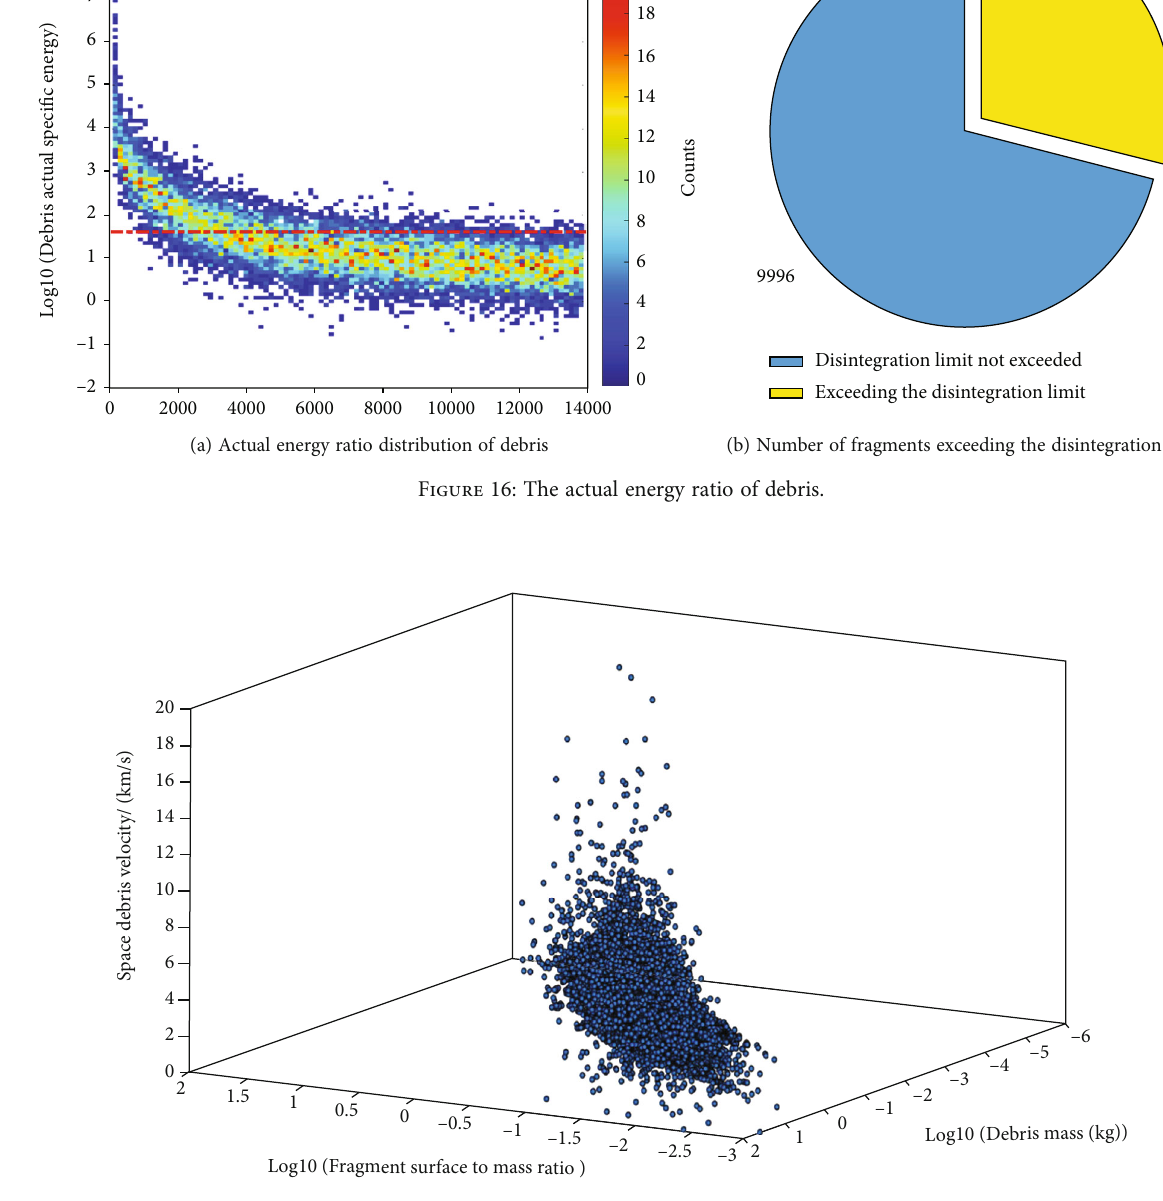
Figure 17: Surface-to-mass ratio and velocity